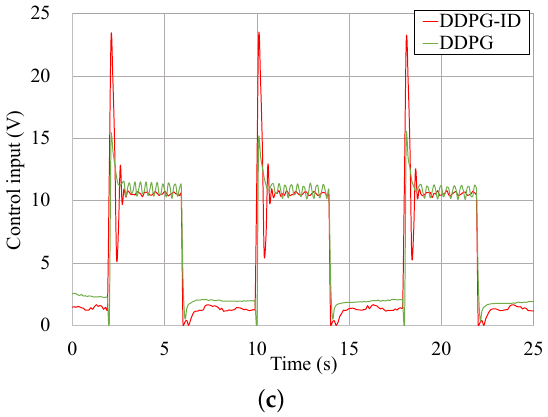
Figure 11. Tracking results comparison of the step trajectory. ( a ) Tracking results comparison based on two control schemes. ( b ) Tracking error comparison based on two control schemes. ( c ) Control input comparison based on two control